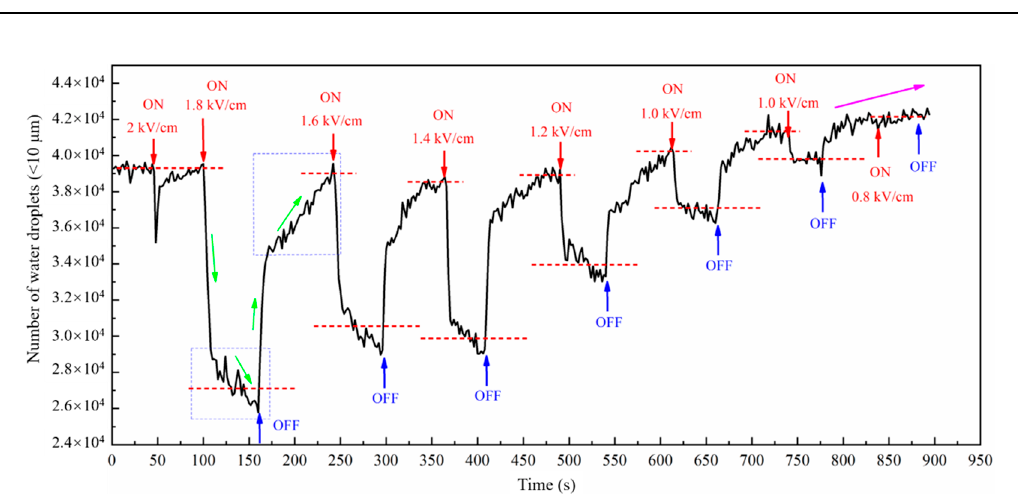
Figure 9. Variations of water droplet number within 50 to 100 μ m.